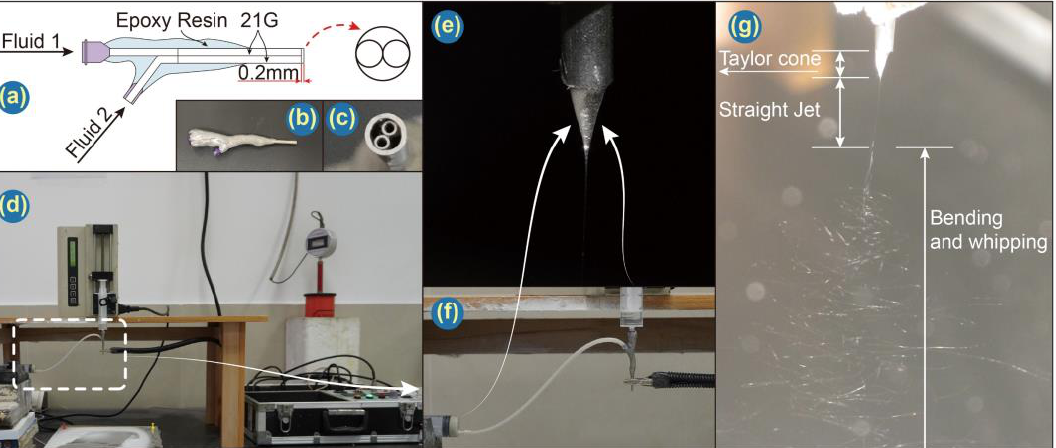
Figure 2. ( a ) Schematic and ( b , c ) photographs of the Janus; ( d ) image of the complete electrospinning apparatus; ( e ) Photograph of the Taylor cone obtained with two working fluids; ( f ) photograph of the working fluids; ( g ) digital image of the electrospinning process. Table 1. Details of the working solutions used in this